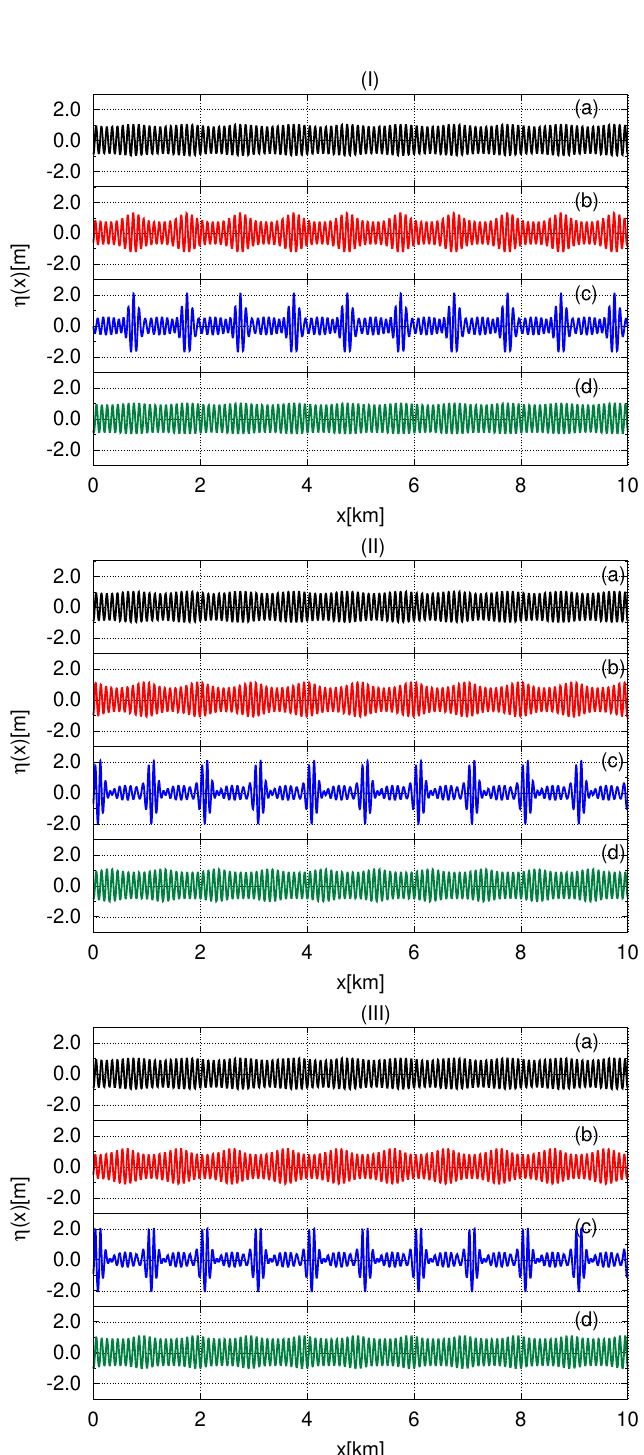
Figure 4. Snapshots of the free surface showing formation and evolution of periodic breathers in different nonlinear models. (I) corresponds to the NLS equation, figure (II) to the SCZ equation, and figure (III) to the RV equations. In each subfigure the panels ( a ) show the initial moment of time t = 0, while the panels ( b ), ( c ) and ( d ) correspond to the moments of time t ≈ 0.7 h, t ≈ 1.2 h and t ≈ 1.8